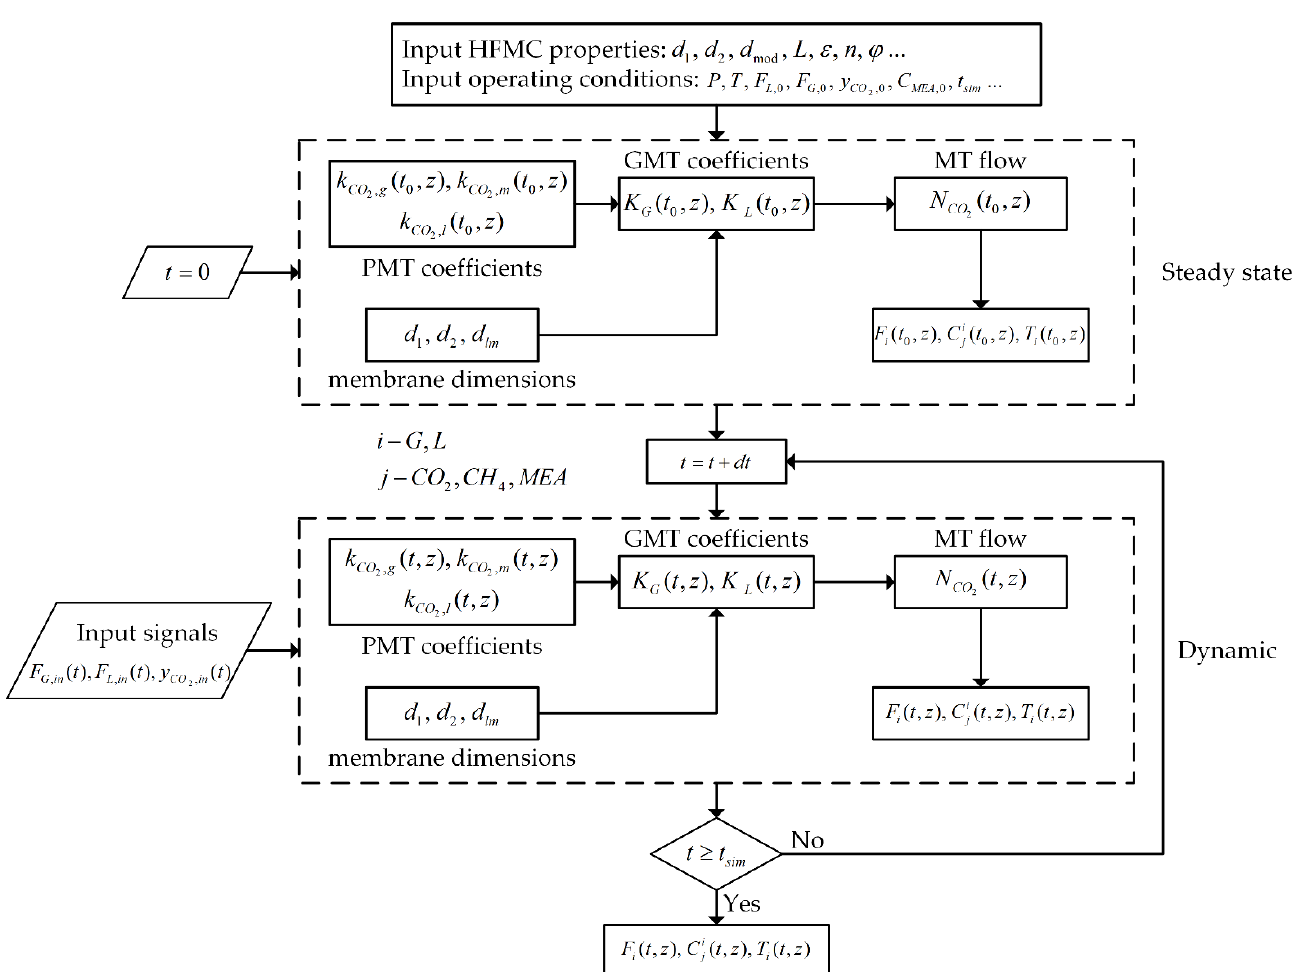
Figure 4. Block flow diagram of the used algorithm.